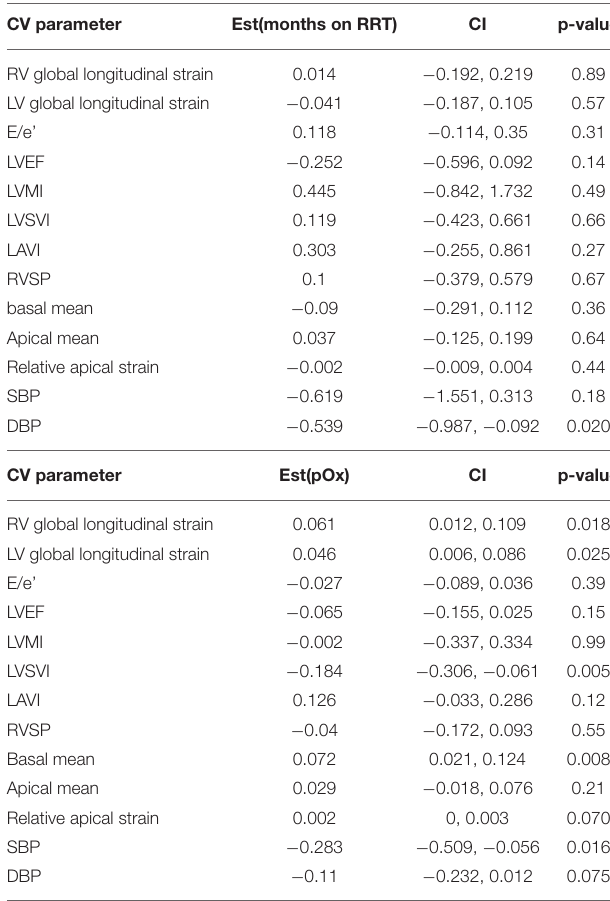
TABLE 7 | Association of changes in echocardiography measures related to time and pOx on RRT in PH patients in linear regression models (up to 30 time points in 13